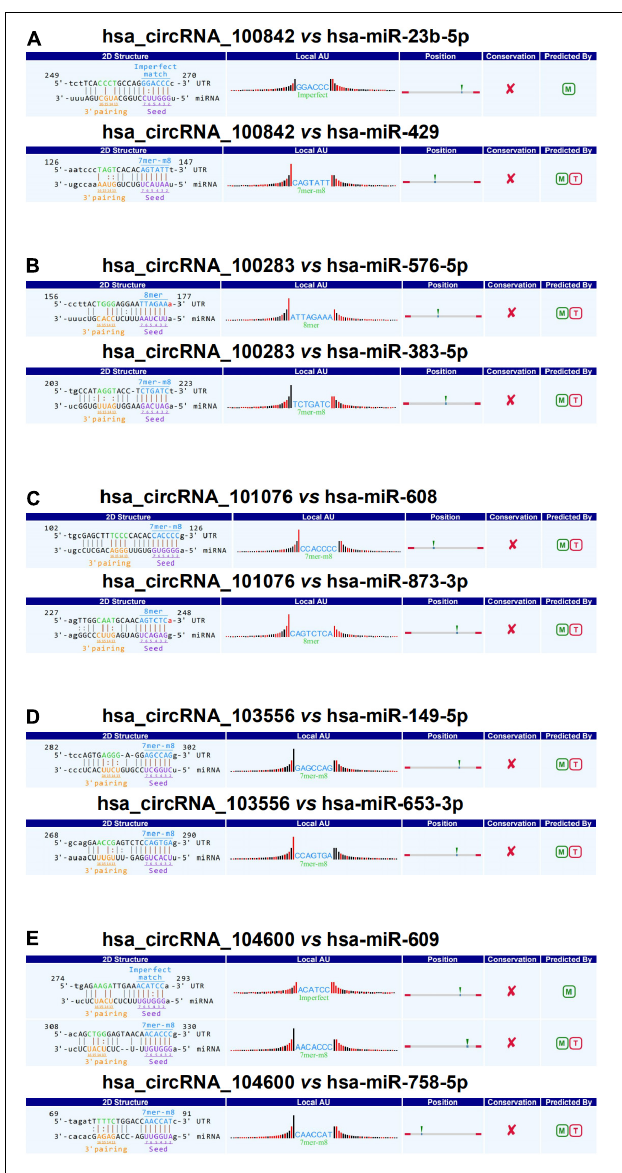
FIGURE 6 | Complementary miRNAs of DEcircRNAs. (A) The 2D structure of the binding sites of hsa_circRNA_100842 (circSLC3A2) with hsa-miR-23b-5p and hsa-miR-429. (B) The 2D structure of the binding sites of hsa_circRNA_100283 (circGCLM) with hsa-miR-576-5p and hsa-miR-383-5p. (C) The 2D structure of the binding sites of hsa_circRNA_101076 (circPCBP2) with hsa-miR-608 and hsa-miR-873-3p. (D) The 2D structure of the binding sites of hsa_circRNA_103556 (circTFRC) with hsa-miR-149-5p and hsa-miR-653-3p. (E) The 2D structure of the binding sites of hsa_circRNA_104600 (circVDAC3) with hsa-miR-609 and hsa-miR-758-5p.